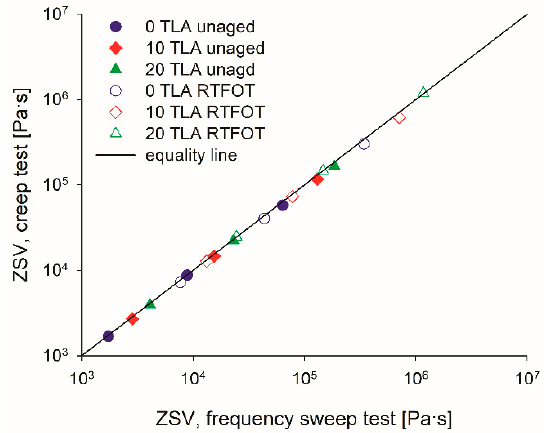
Figure 11. Comparison of the ZSV values of the tested binders from creep test and Cross model before and after